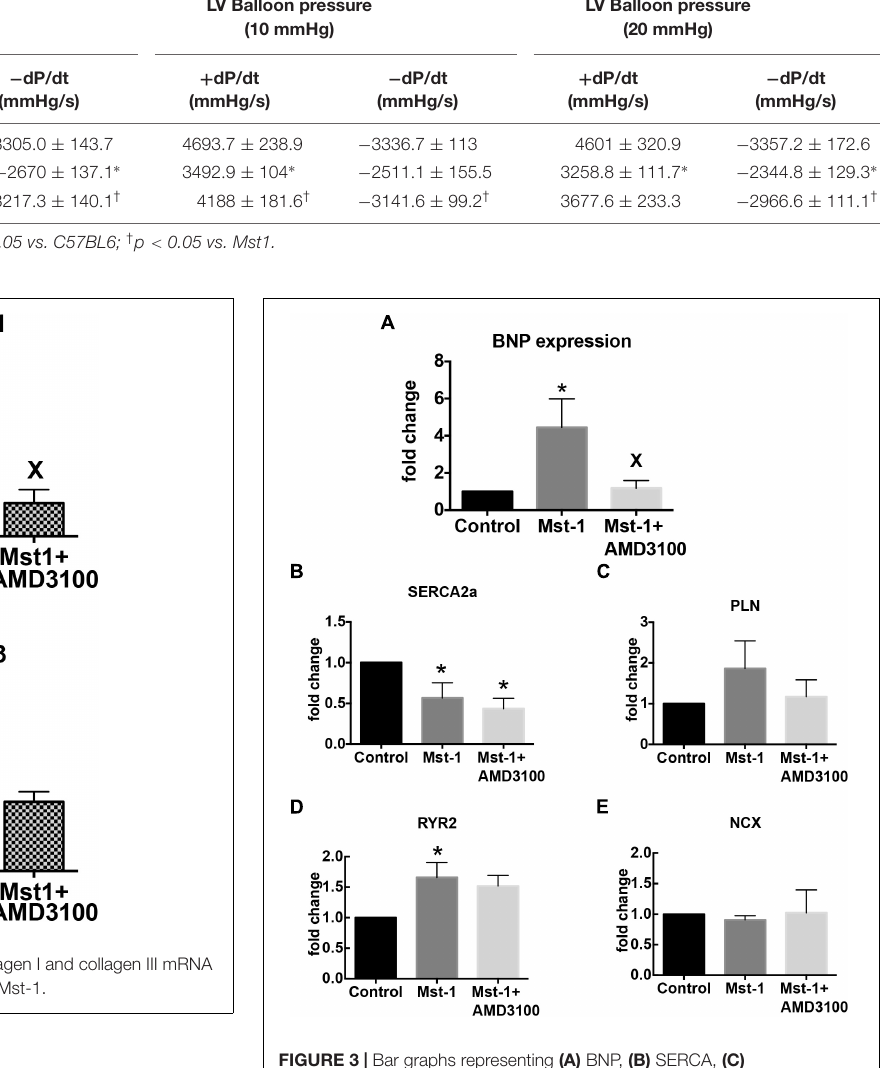
FIGURE 3 | Bar graphs representing (A) BNP, (B) SERCA, (C) phospholamban, (D) ryanodine receptor, and (E) sodium-calcium exchanger mRNA expression. ∗ p < 0.05 vs. control; X p < 0.05 vs.